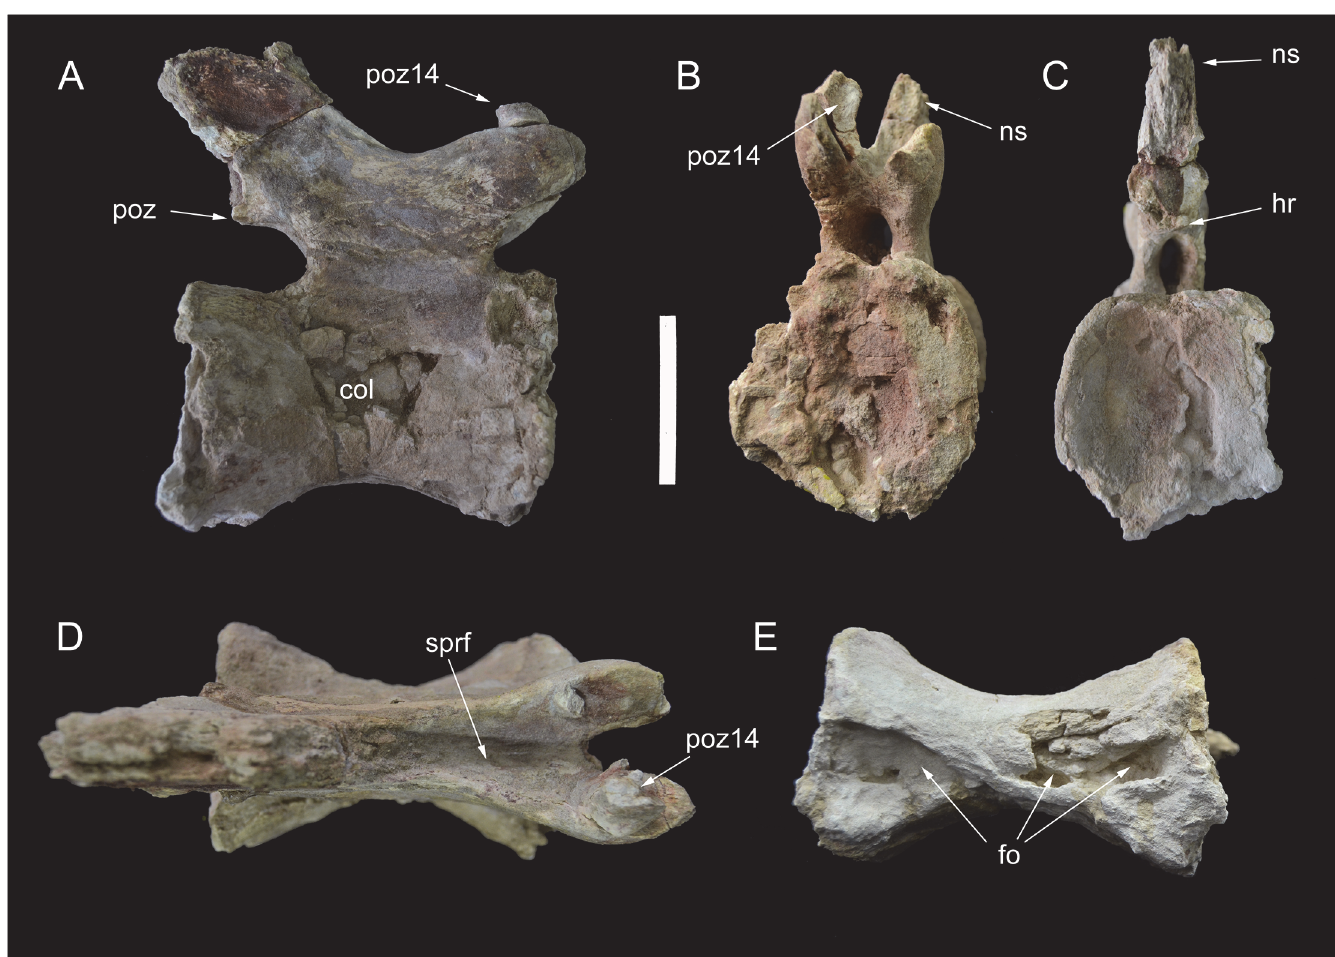
Fig 16. Caudal vertebra 15 of Tataouionea hannibalis . Vertebra in right lateral (A), proximal (B), distal (C), dorsal (D) and ventral (E) views. Scale bar: 10 cm. Abbreviations: col, collapsed area; fo, fossa; hr, hyposphenal ridge; ns, neural spine; poz, postzygapophysis; poz14, right caudal 14 postzygapophysis fragment; sprf, spinoprezygapophyseal